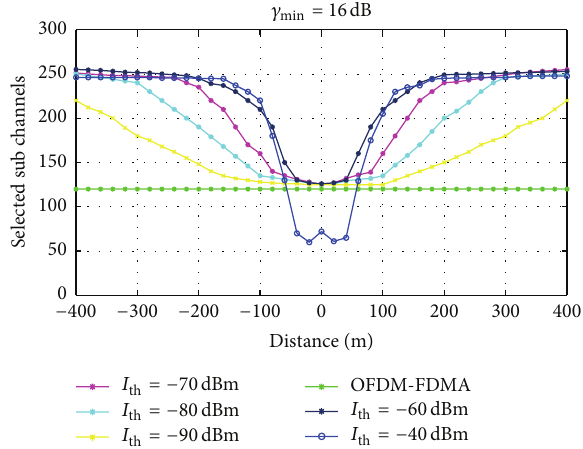
Figure 6: The number of selected sub-channels with different thresholds and conventional OFDM-FDMA.